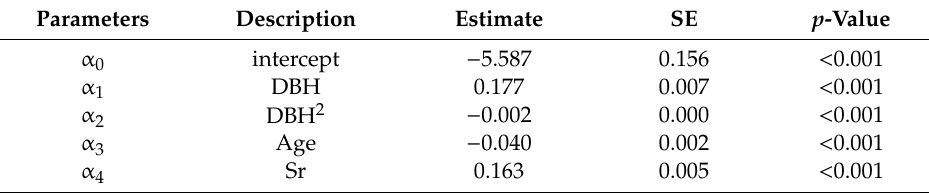
Table 6. Summary of parameter estimation using Sr for TIS